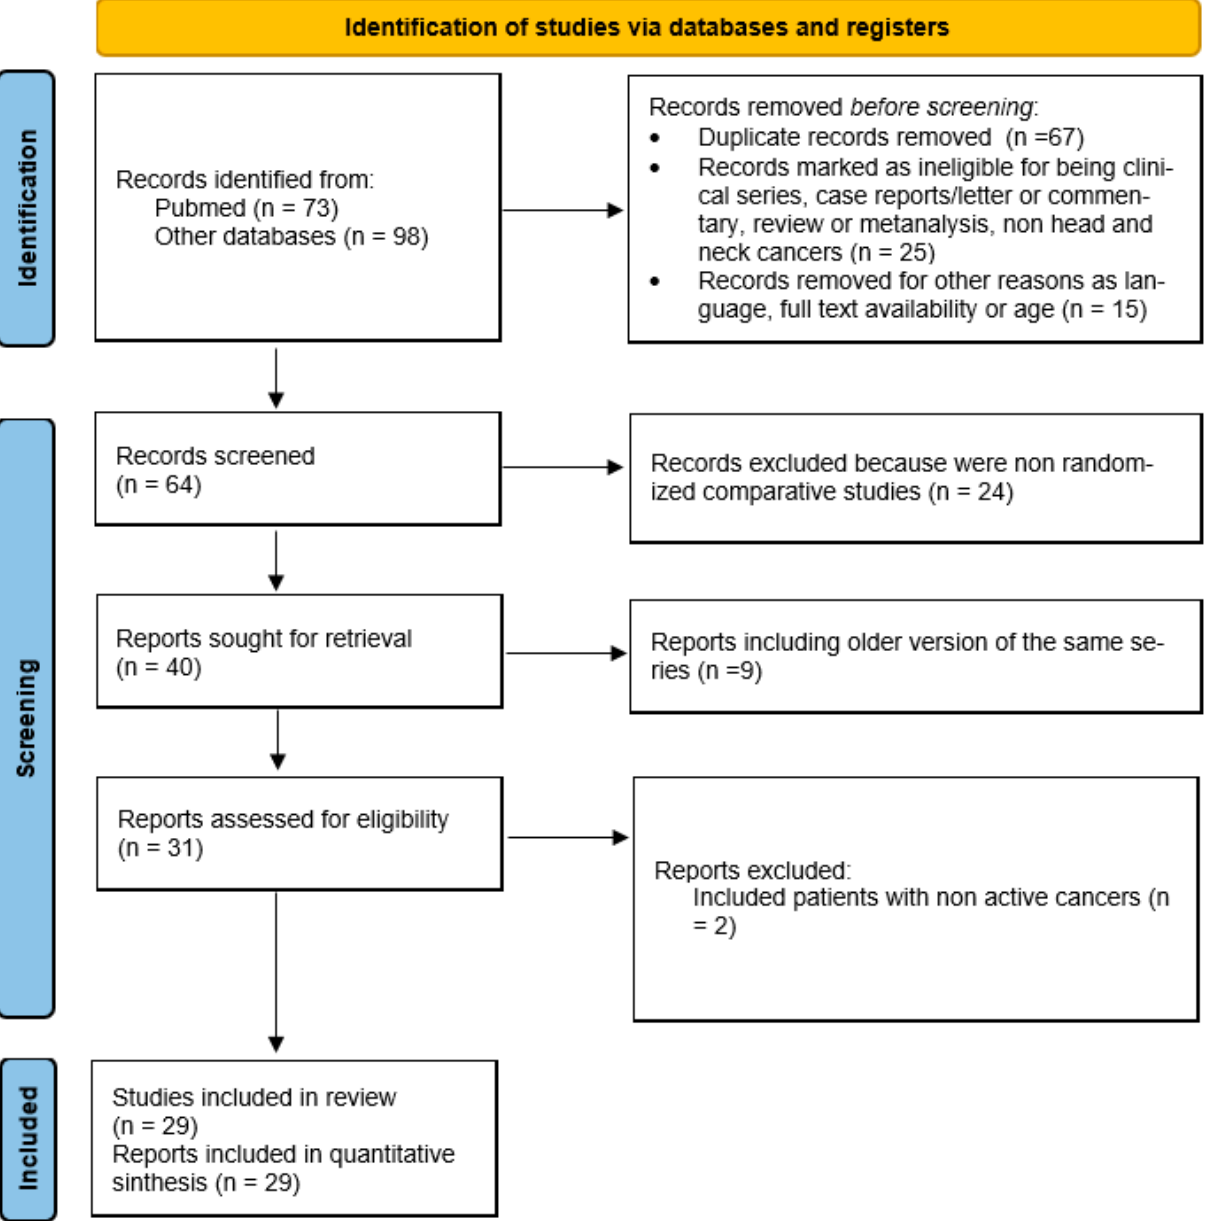
Figure 1. flow diagram of included studies. Figure 1. Flow diagram of included